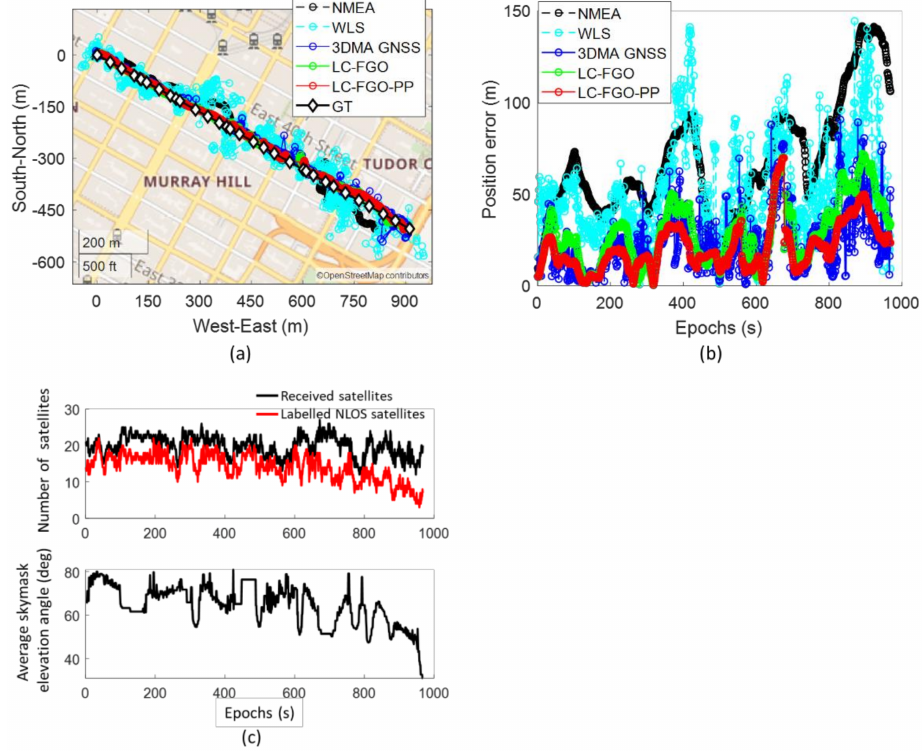
Figure 7. ( a ) map plot, ( b ) positioning errors, and ( c ) number of received satellites and average skymask elevation angle of bad positioning trip (Trip